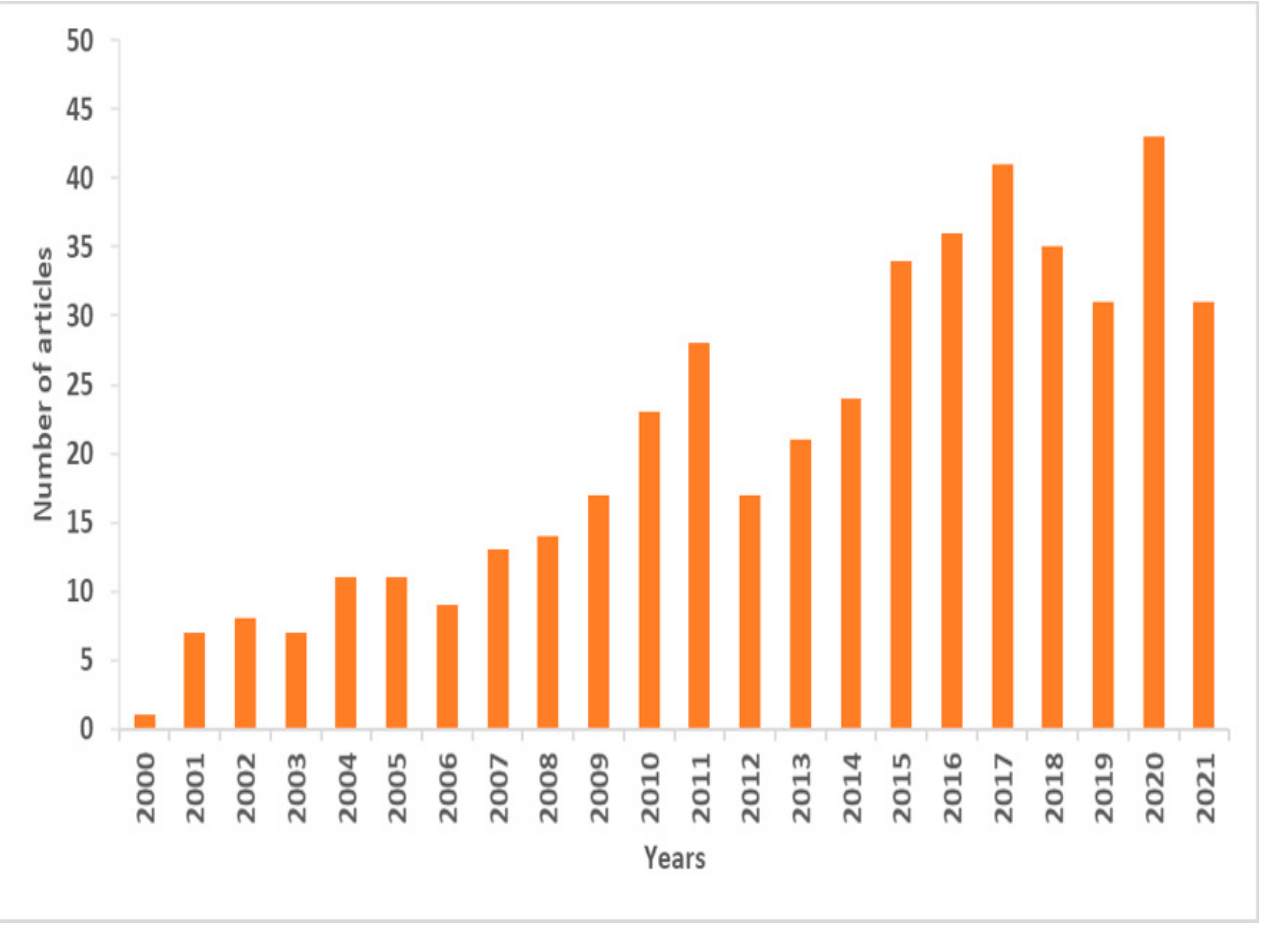
Figure 2. Number of articles on “Extreme rainfall events” published from 2000 to 2021 ( n = 462).